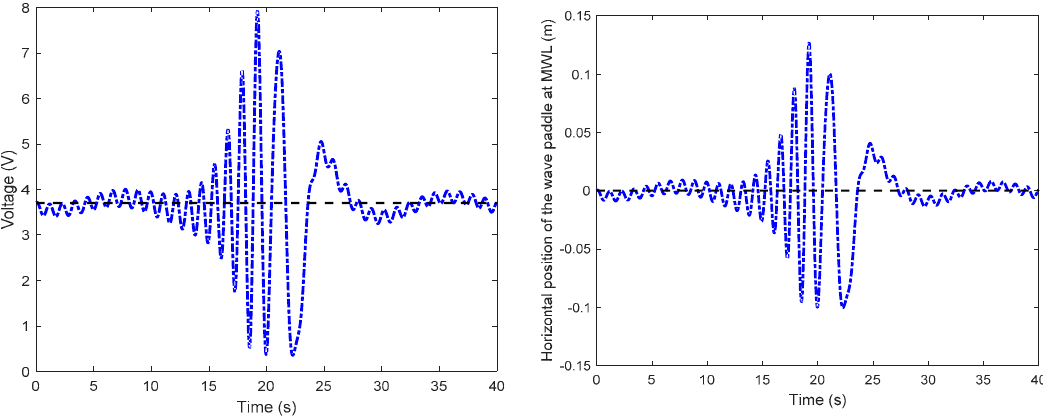
Figure A1. The temporal evolution of the input voltage (the left panel) and the horizontal position of the wave paddle at the mean water level (z = 1.5 m).